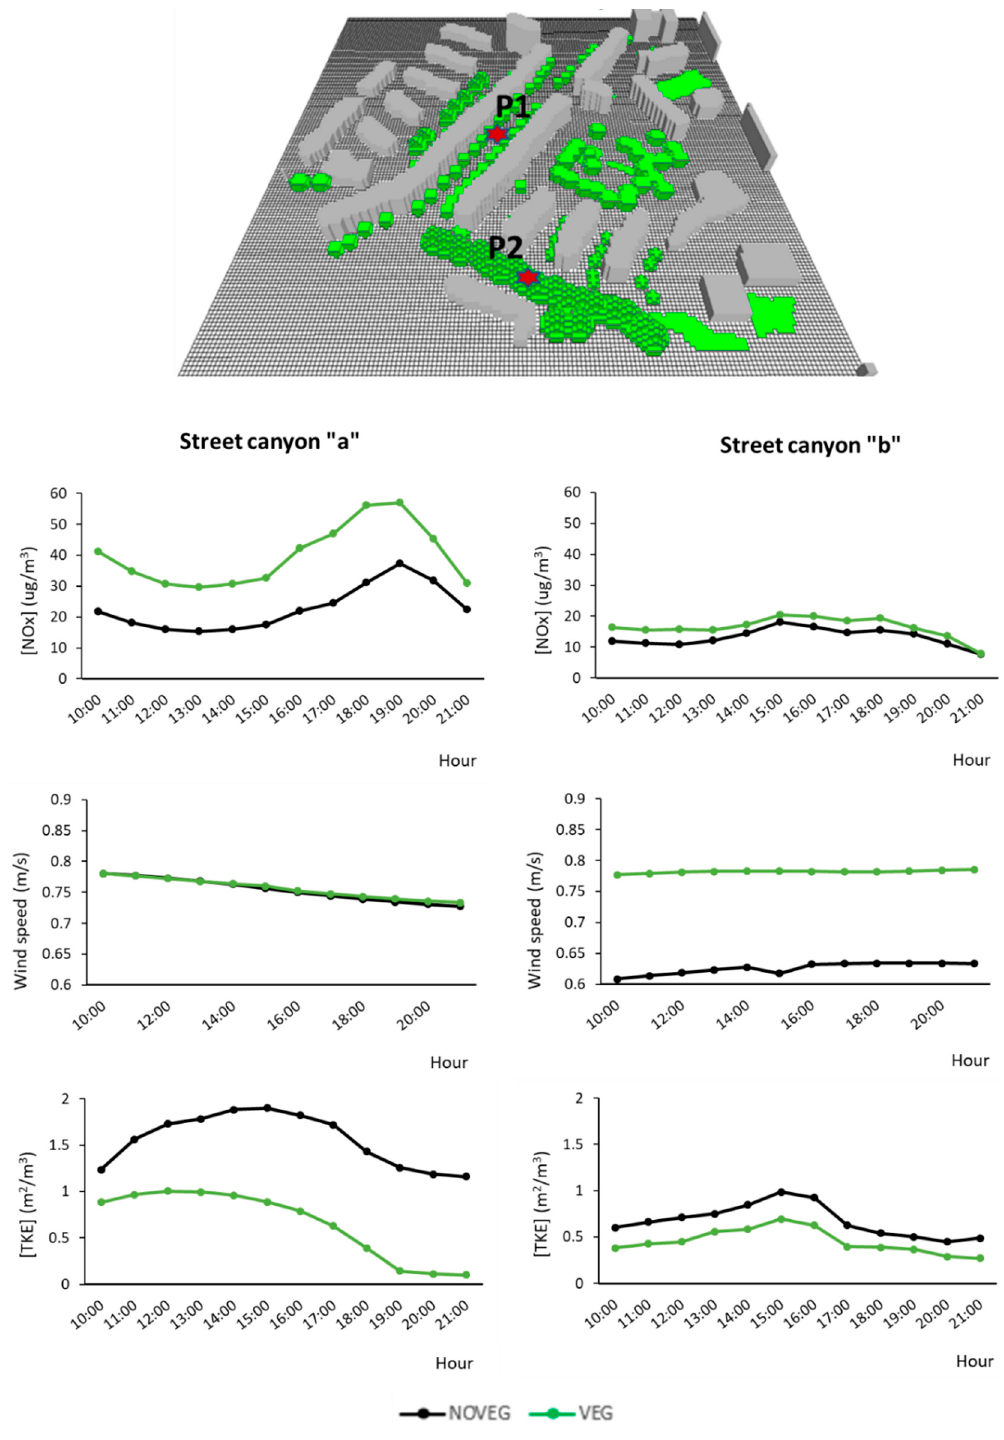
Figure 7. Top: extraction points P1 (street canyon “a”) and P2 (street canyon “b”). Hourly profiles of NOx concentration, wind velocity, and turbulent kinetic energy (TKE) obtained from ENVI-met on 7 July 2019 for the scenario without vegetation (NOVEG) and the current one with vegetation (VEG) in street canyons “a” and “b”.